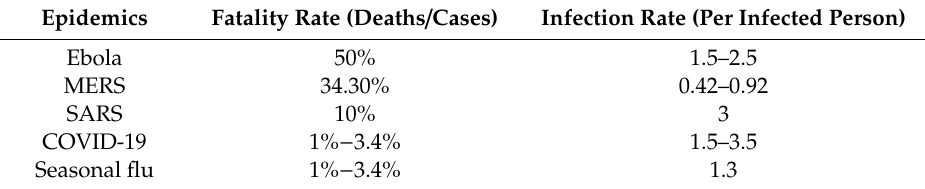
Table 1. Fatality Rates and Infection Rates of COVID-19 and Other Epidemics.